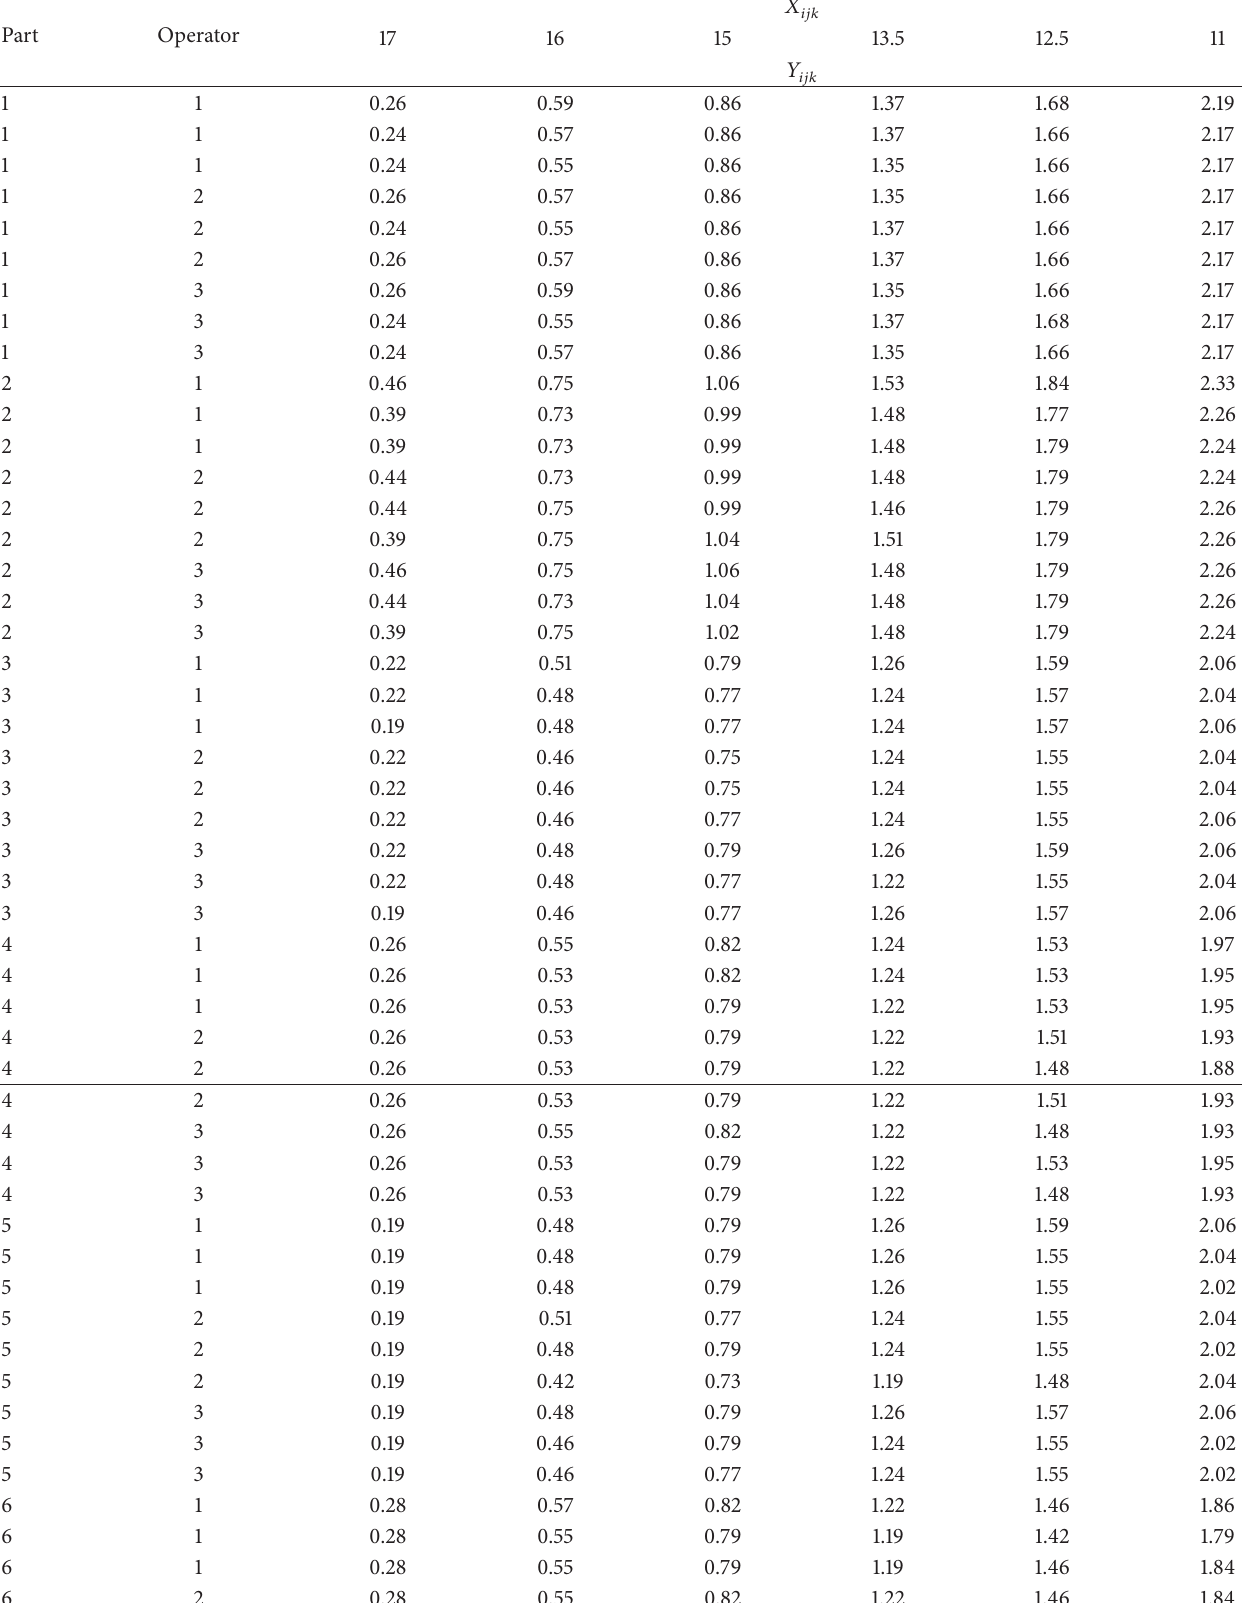
Table 3: The measured data of spring